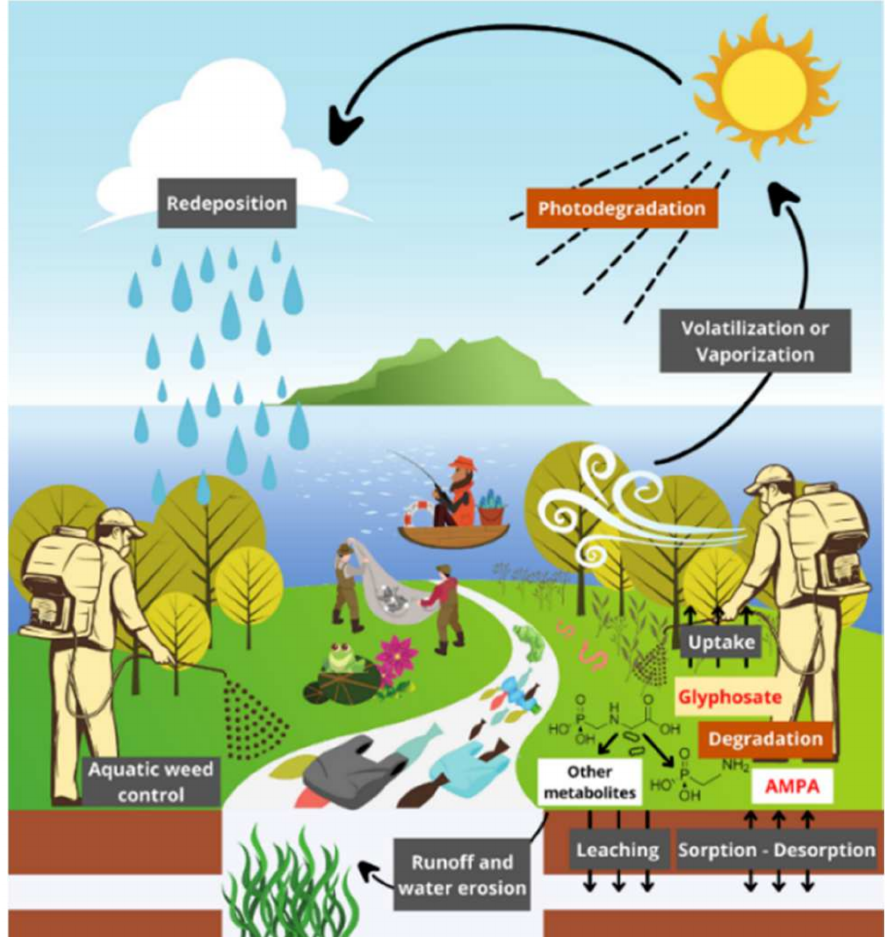
Figure 3. Glyphosate fate and